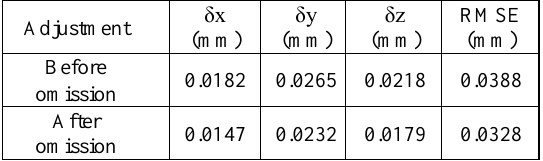
Table 3. The results of bundle adjustment of the propeller before and after omission of images with low fuzzy values The result of Table 3 shows that the accuracy of bundle adjustment proves after omission of stations with low fuzzy values. Moreover, camera station error ellipsoids for the propeller before and after omission of improper images are shown in Figure 4 in the same scale of 500 greater. Figure 4 shows that after omission of improper images, the rest of error ellipsoids growing smaller.